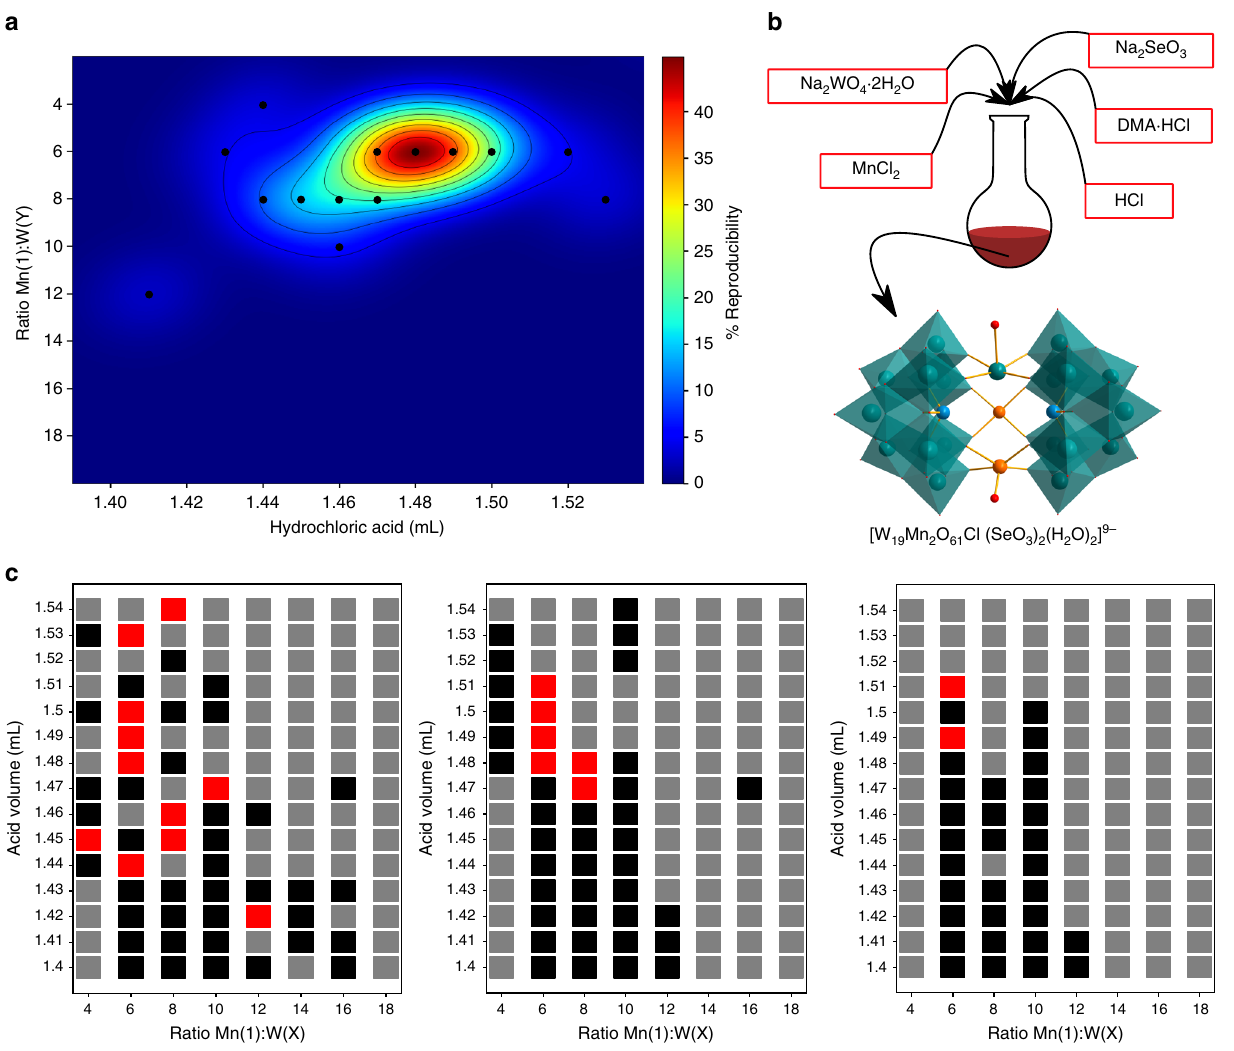
Fig. 6 Reproducibility of POM crystallisation. a Heat map of % reproducibility of each conditions that produced crystals at least once. b One-pot synthesis of the W 19 Mn 2 Se 2 polyoxometalate cluster with accompanying structure. c Three automated grid search results of reaction space (red = crystals, grey = precipitate, black = no